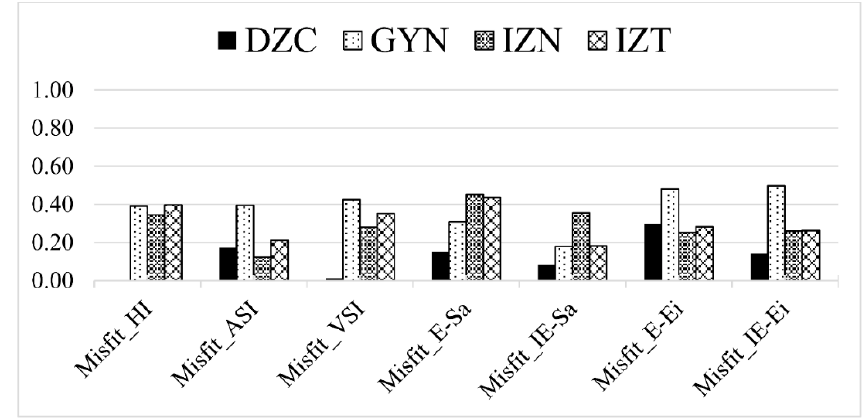
Figure 7. Engineering demand log-scale misfits in terms of HI, ASI, VSI, E-S a , IE-S a , E-Ei, and IE-Ei between the real and simulated records of the Erzincan event.